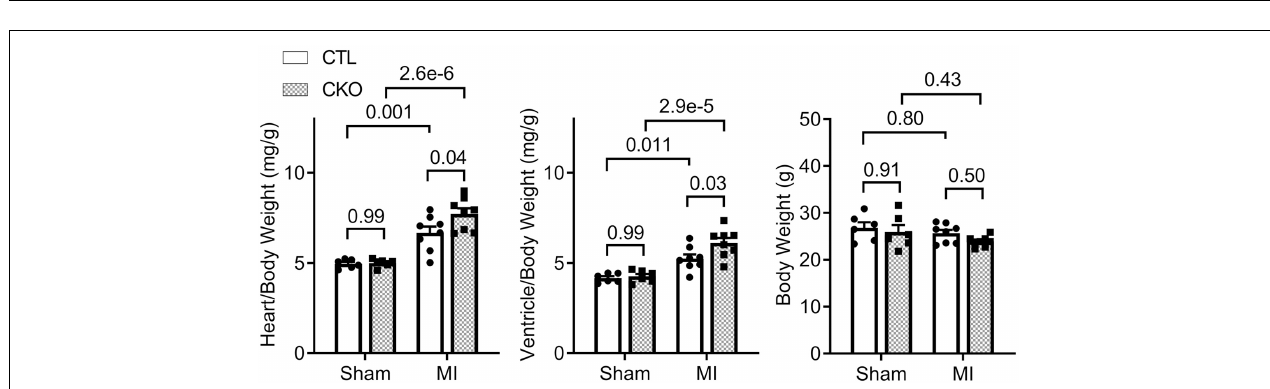
FIGURE 7 | Western blot analyses for myocardial Uchl1 and total Ub conjugates in control (CTL) and Uchl1-cko (CKO) mice 28 days post-MI or sham surgery. The peri-infarct area (Peri-IF) and the remote area of the same hearts of the MI group as well as the equivalent areas of the sham group were analyzed. Shown are the representative images (A,B) and pooled densitometry data (C–F) . N = 3 mice (1 male + 2 females) for each group; the p -value of the pair-wise comparison shown above the bracket is derived from two-way ANOVA followed by Tukey’s tests.